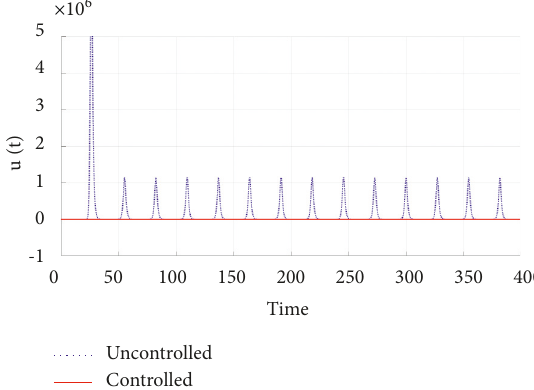
Figure 7: Comparison of controlled and uncontrolled free virions.